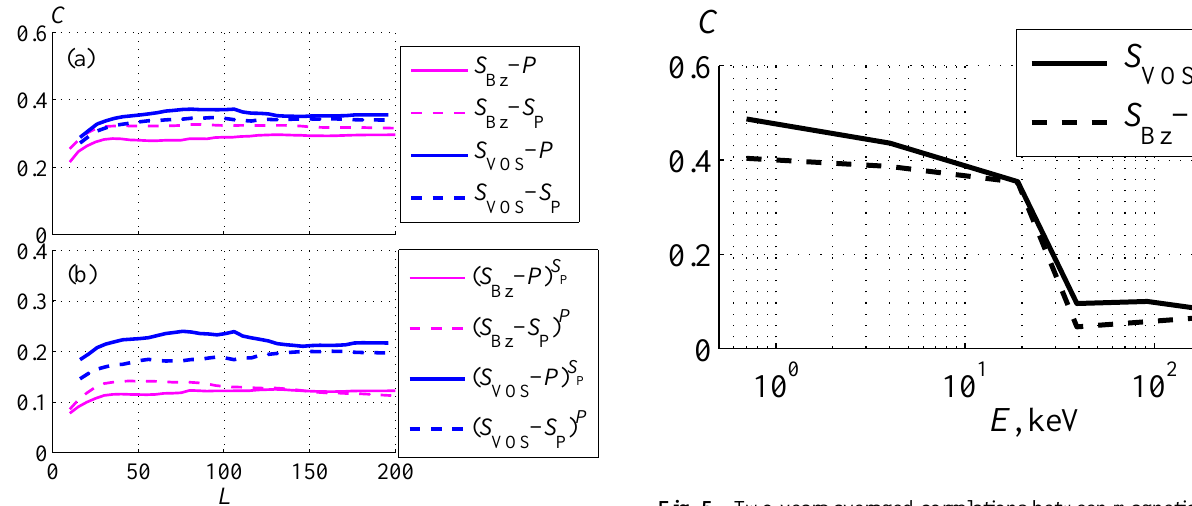
Fig. 5. Two years averaged correlations between magnetic fluctu- ations in the polar cap S VOS (solid) and in the interplanetary space at WIND S Bz (dashed) and interplanetary proton fluxes in respect to energy at L = 30.